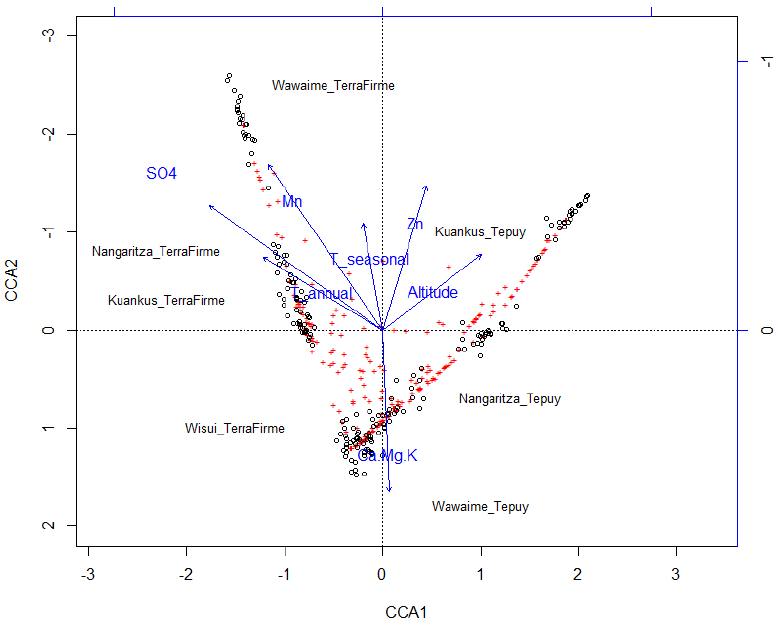
Figure 4. The canonical ordering analysis (CCA) ordination showing grouping at subplot level. N = 200 subplots of 400 m 2 .